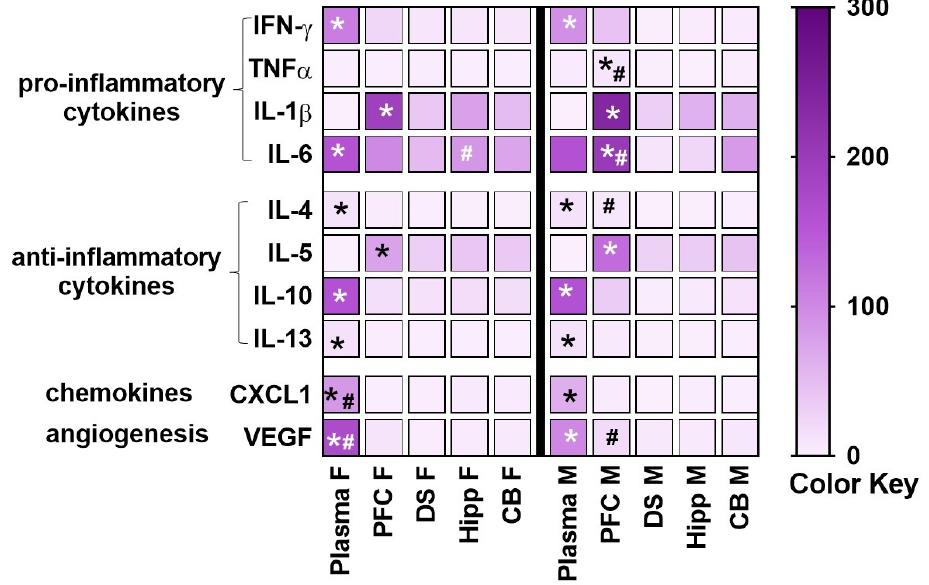
Figure 2. A heatmap was generated to display 10 different measured inflammatory markers in healthy control (saline treated) female (F) and male (M) rats in plasma and brain tissue homogenates. Mean values without standard error are indicated in the heatmap. However, statistical analysis was performed on mean ± S.E.M. values. Prefrontal cortex, PFC; dorsal striatum, DS; hippocampus, Hipp; cerebellum, CB. White to purple transitions (color key; pg/mL) indicate, respectively, low to high average cytokine or chemokine or VEGF concentration. Data are represented as mean. n = 4 control female, n = 2–3 control male. * p < 0.05 vs. all other samples within each sex, # p < 0.05 vs. the opposite sex by post-hoc tests. CXCL1: main effect of regions (F4, 21 = 91.8, p < 0.001) without an interaction or main